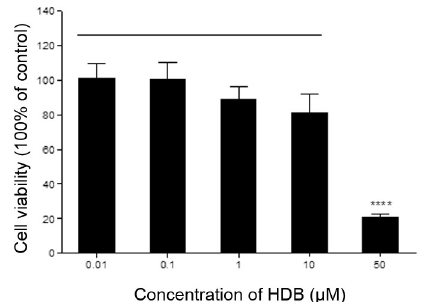
FIGURE 3 - Cytotoxicity of HDB on SH-SY5Y cells. After treated with 0.01, 0.1, 1, 10 and 50 µM of HDB for 48 h, cell growth was assayed by CCK-8 Kit at 450 nm. Values indicate the mean ± SD ( n = 6). **** P <0.01 compared to 0.01-10 µM of